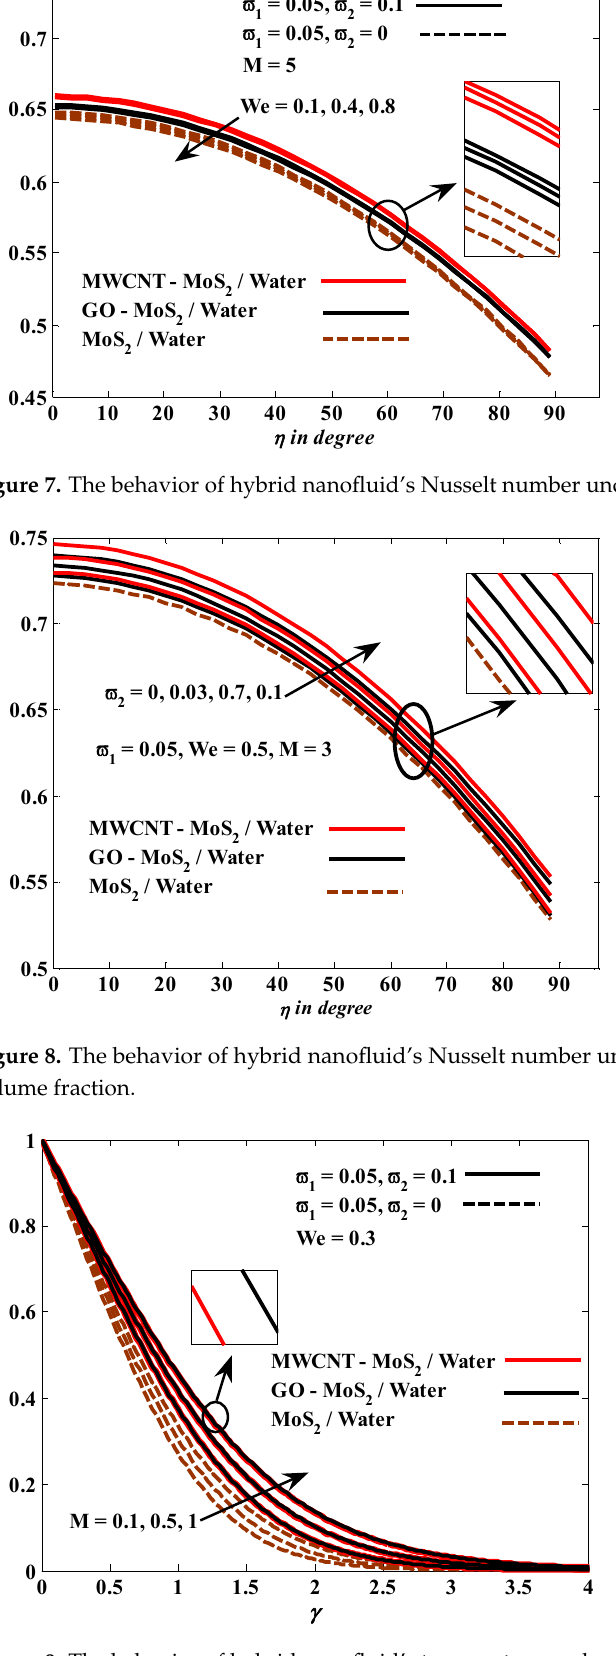
Figure 10. The behavior of hybrid nanofluid’s temperature under the effect of We.